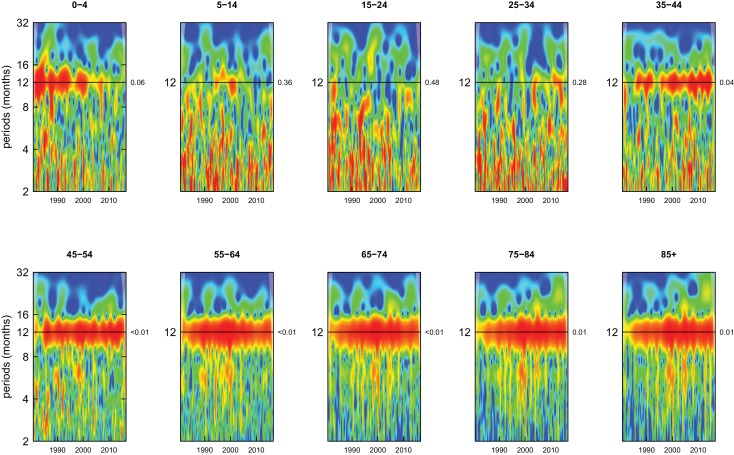
Wavelet power spectra for national time series of chronic respiratory disease death rates for 1980–2016, by age group for females.Wavelet power values increase from blue to red. The shaded regions at the left and right edge of each box indicate the cone of influence, where spectral analysis is less robust. P-values for the presence of 12 month seasonality are to the right of each figure at the 12 month line.